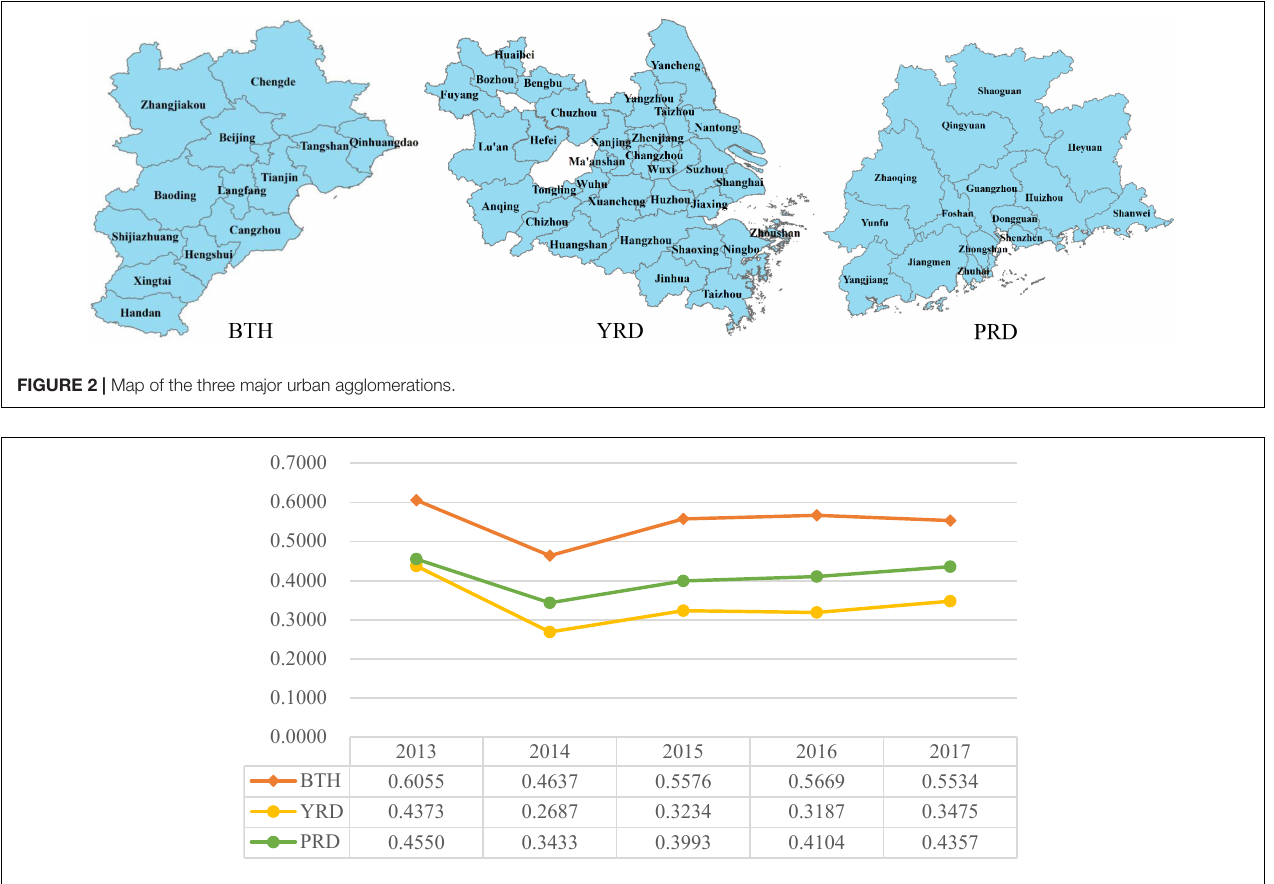
FIGURE 3 | Change of annual average efficiency of China’s three major urban agglomerations,